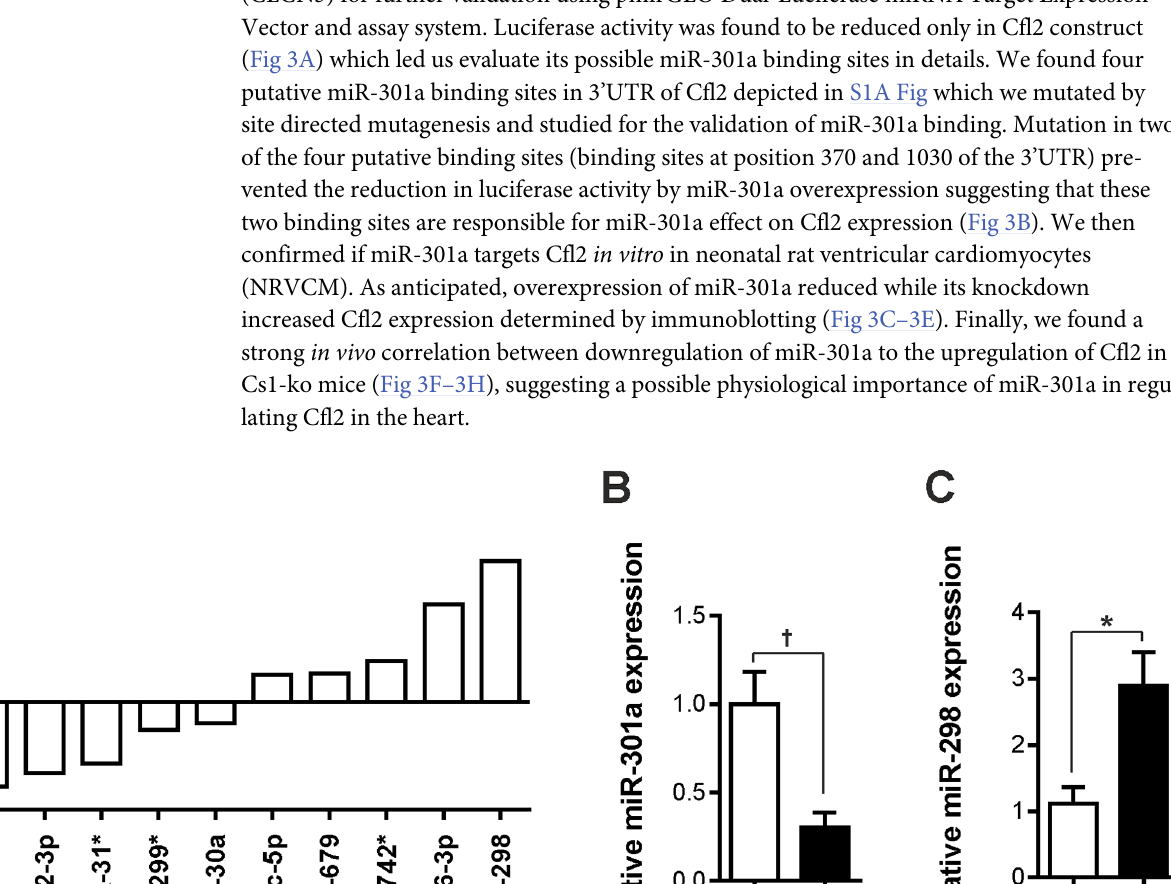
PLOS ONE | https://doi.org/10.1371/journal.pone.0183901 September 8,